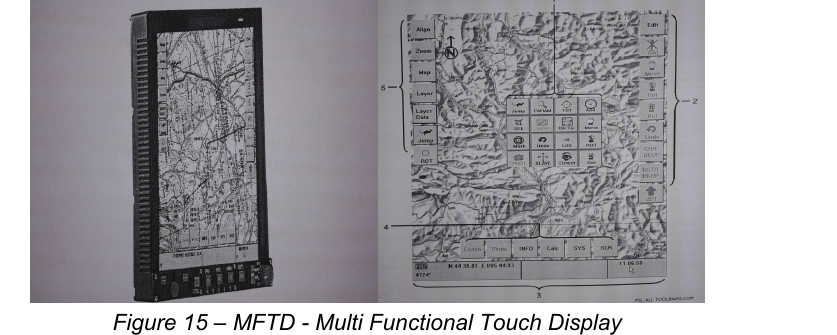
Figure 15 – MFTD - Multi Functional Touch